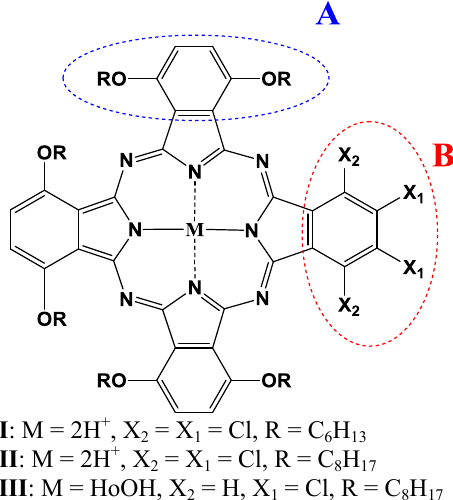
Fig. 1. Structural formula of the studied phthalocyanine